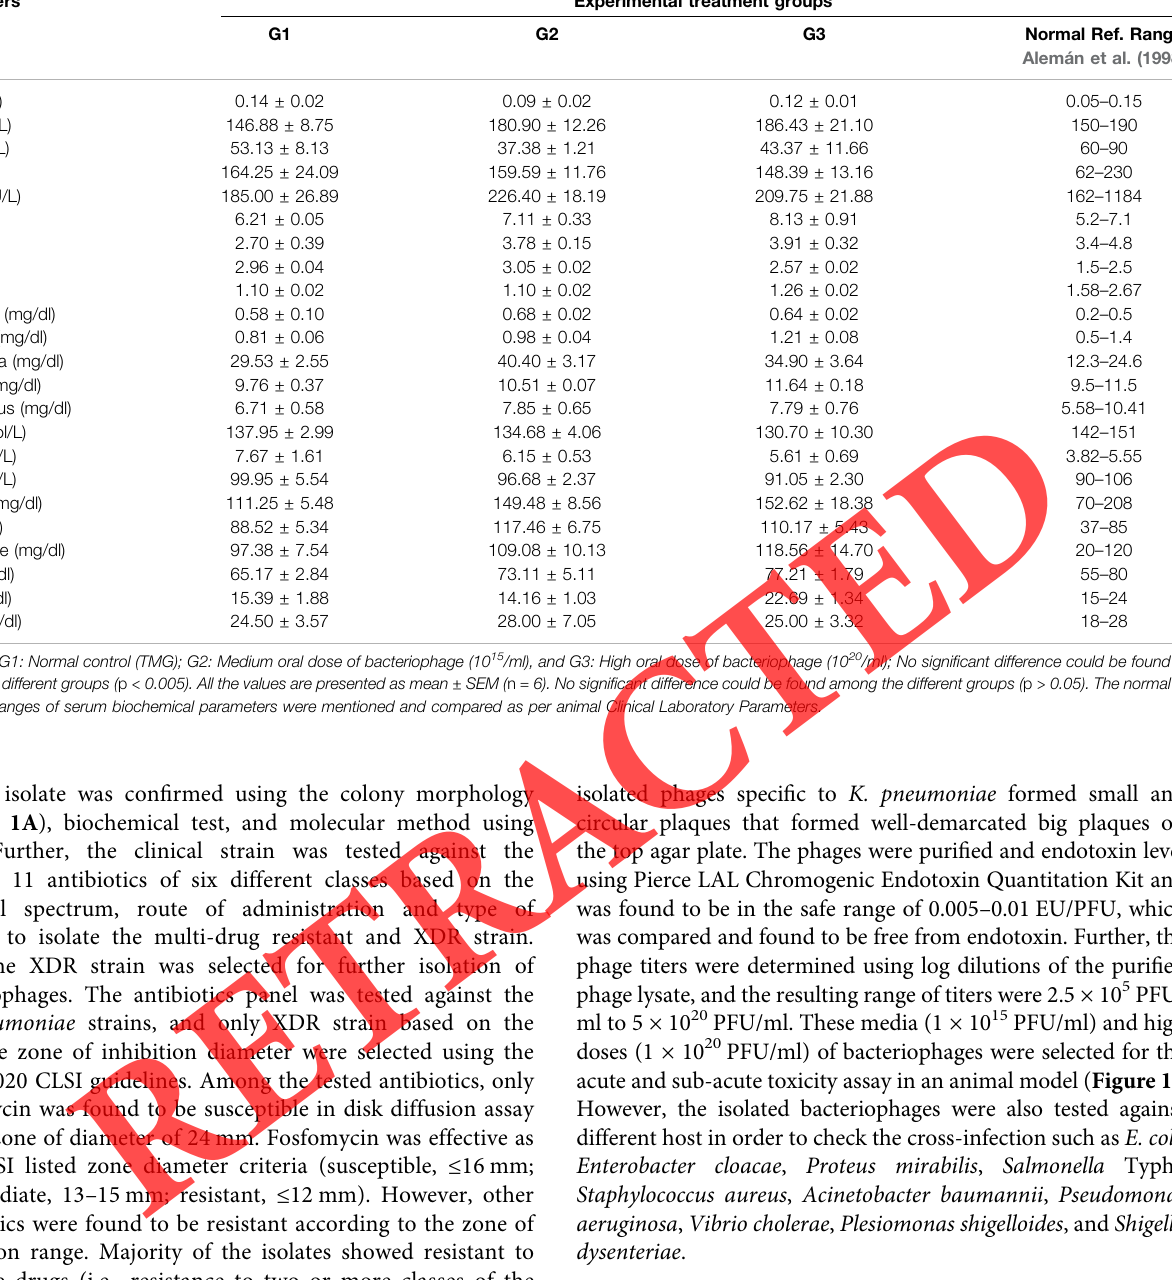
TABLE 3 | Effect of treatment with the bacteriophages on the level of serum biochemical analysis in Charles foster rats. Parameters Experimental treatment groups G1 Normal Ref. Range